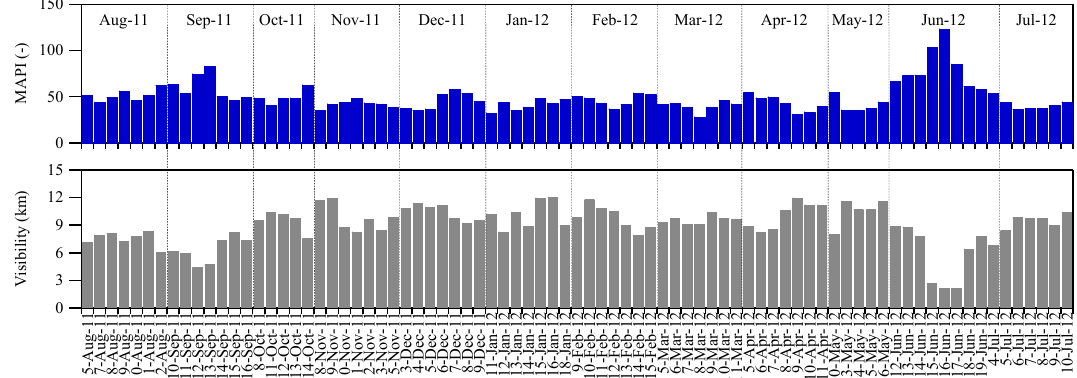
Figure 1. Daily variability of the MAPI and visibility during the sampling periods.